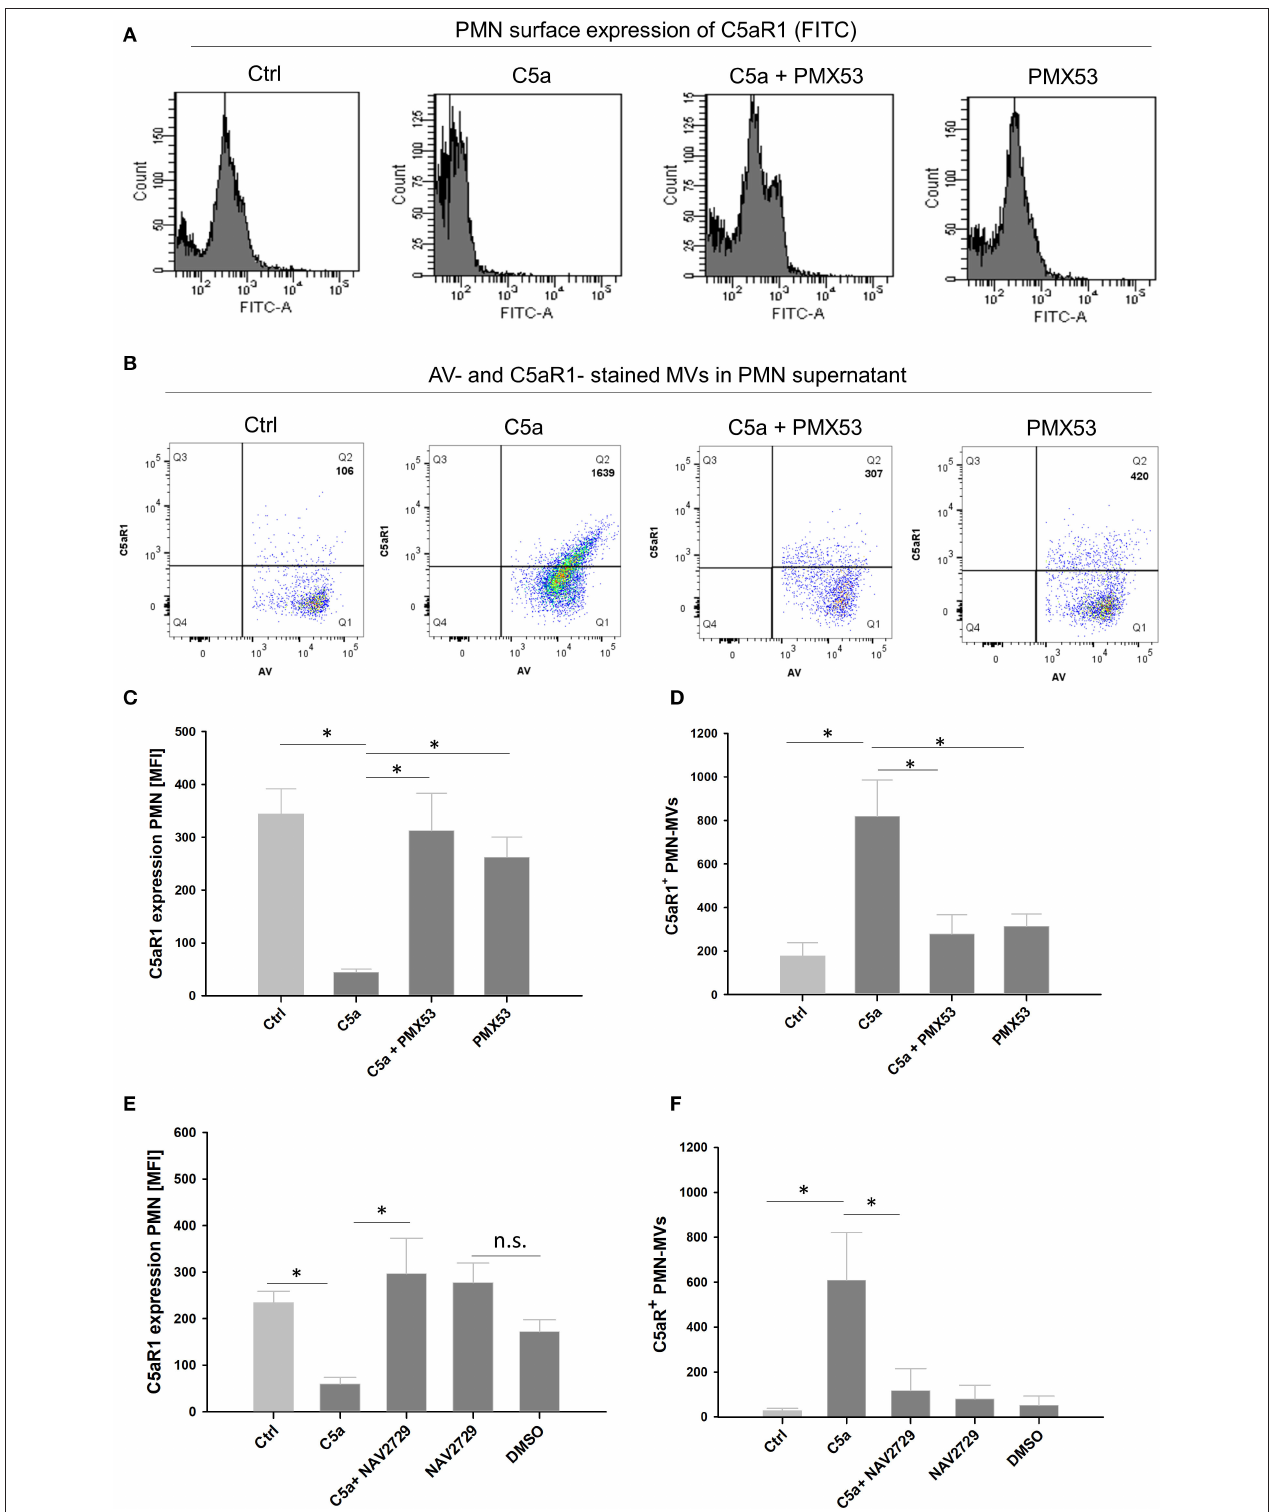
FIGURE 5 | PMX53 and NAV2729 show similar effects in blocking C5aR1-positive MV shedding. Representative flow cytometry panels for C5aR1 expression (FITC) (A) on PMNs or (B) in PMN supernatants including C5aR1 + MV counts in Q2 after 1h stimulation in the presence of PMX53. Quantitative analysis of flow cytometry data showing (C) C5aR1 expression on PMN surfaces (FITC MFI) and (D) C5aR1 + MV counts. Quantitative flow cytometry analysis including the MV-specific inhibitor NAV2729 (10 µ M) (E) for C5aR1 expression (FITC MFI) on PMNs and (F) C5aR1 + MV counts in 10 µ l PMN supernatants after 1h, n = 4 per group, respectively. * p <